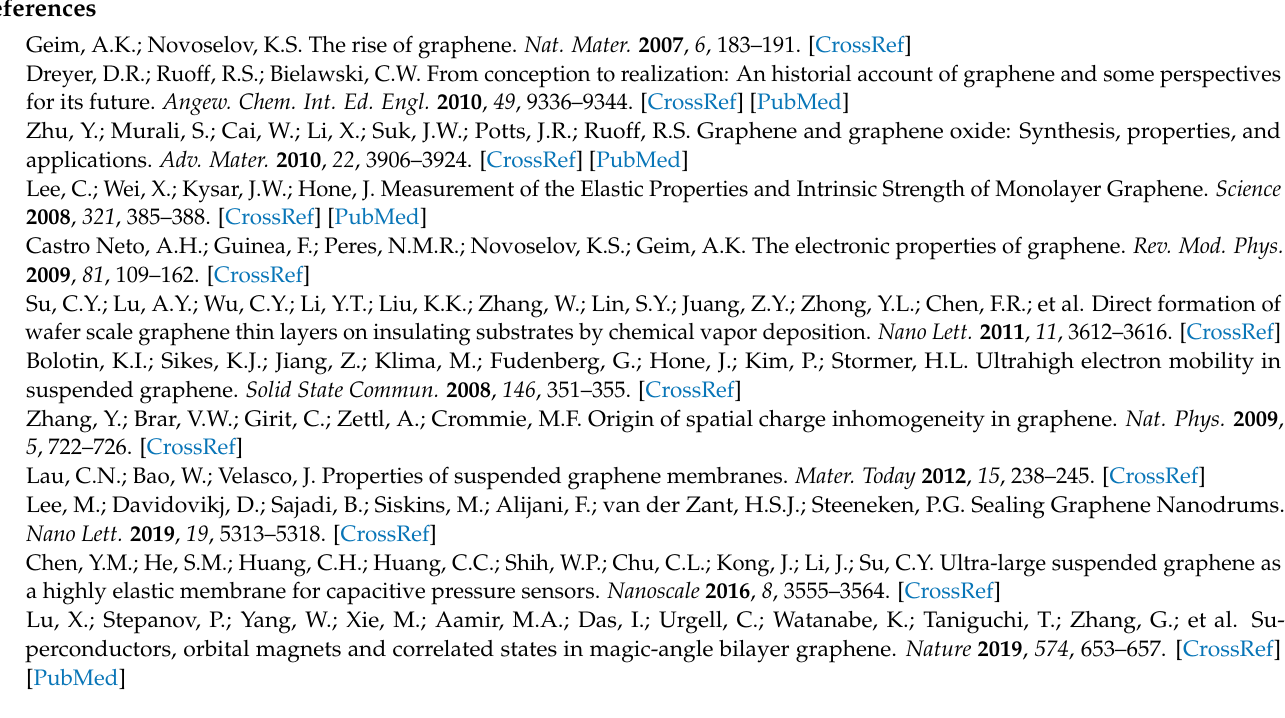
process; Figure S2. Thermal release tape transfer graphene surface morphology. Figure S3. (a)–(d) Raman mapping of CV-grown graphene. (e) SEM of CVD-grown 3L and 6L graphene films on Cu foil. (f) Optical micrographs of graphene crystal domains in size. (g) Transparency comparison of CVD-grown graphene films. (h) sheet resistances of graphene films, which were averaged from 10 randomly selected places on each film. Figure S4. (a) CVD-grown 3L suspended graphene, with cracks indicated by red arrows. (b) CVD-grown 6L suspended graphene without cracks. Figure S5. (a) The state of the back of the hole in the etch. (b) Morphology of a fully ruptured graphene hole. (c,d) Enlarged view of the red dashed box in Figure (b). Figure S6. (a) The state of the film after failure following nanoindentation testing. (b–e) Results of nanoindentation tests for CVD-grown 3L, 6L and stacked 2L,4L. (f) Comparison of nanoindentation test results for stacked 2L and CVD-grown 3L. Figure S7. (a) Schematic diagram of graphene growth distribution on the surface of Cu ladder. (b) Growth of suspended graphene without stacked folds. Figure S8. (a) Schematic diagram of graphene crack stacking. (b) Schematic diagram of graphene fold